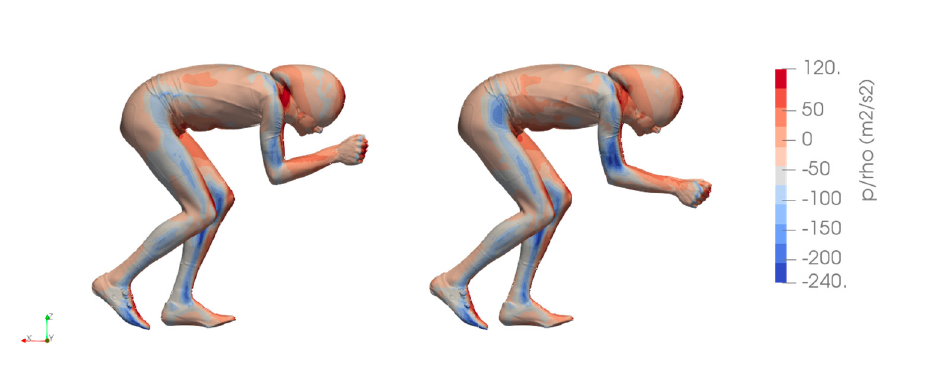
Figure 4. Comparison of relative pressure, 𝑝/𝜌 [m 2 /s 2 ], on cyclist body between base position and maximum elbow